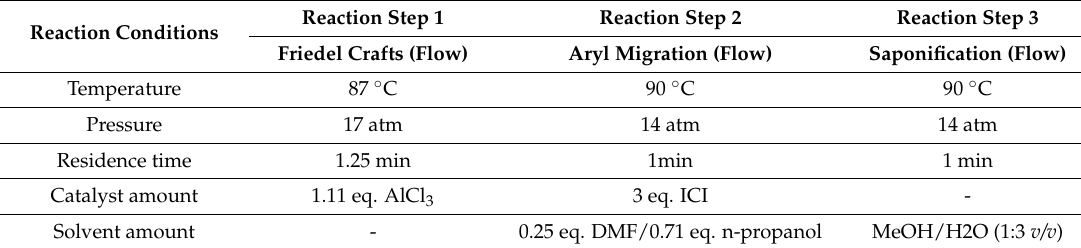
Table 13. Reaction Conditions for the three reactive steps.